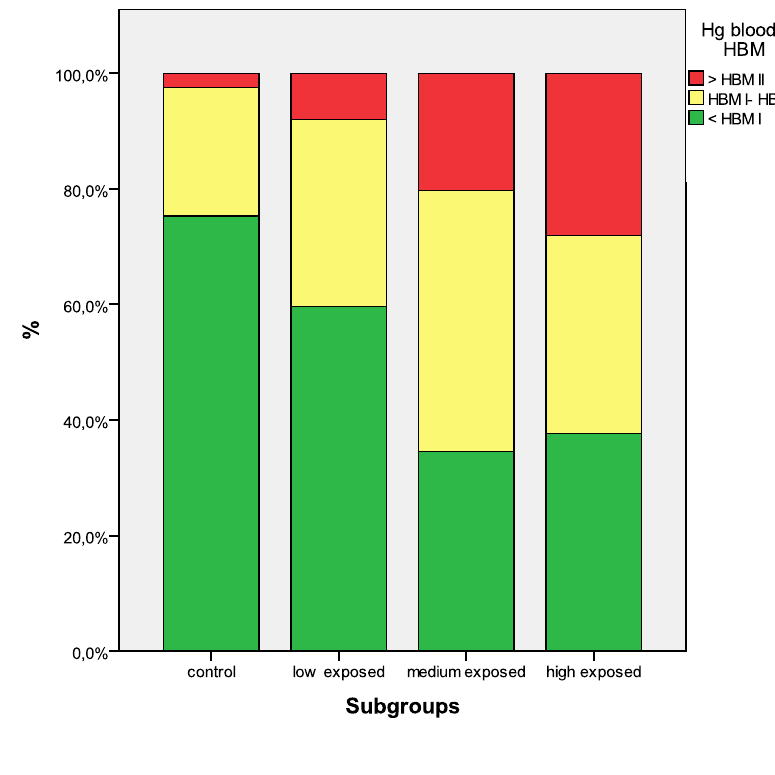
Figure 7. Mercury in blood—stacked bar chart for threshold